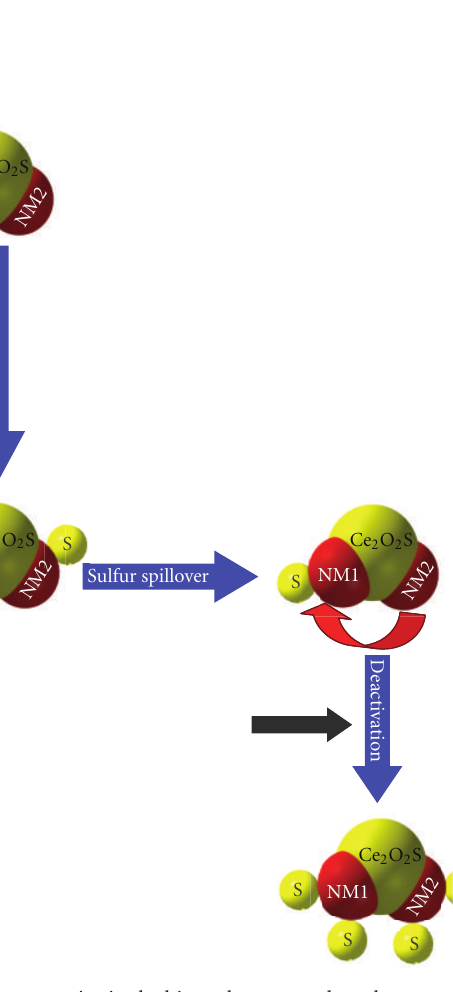
Figure 14: Phenomenological mechanism operative in the bimetal-supported